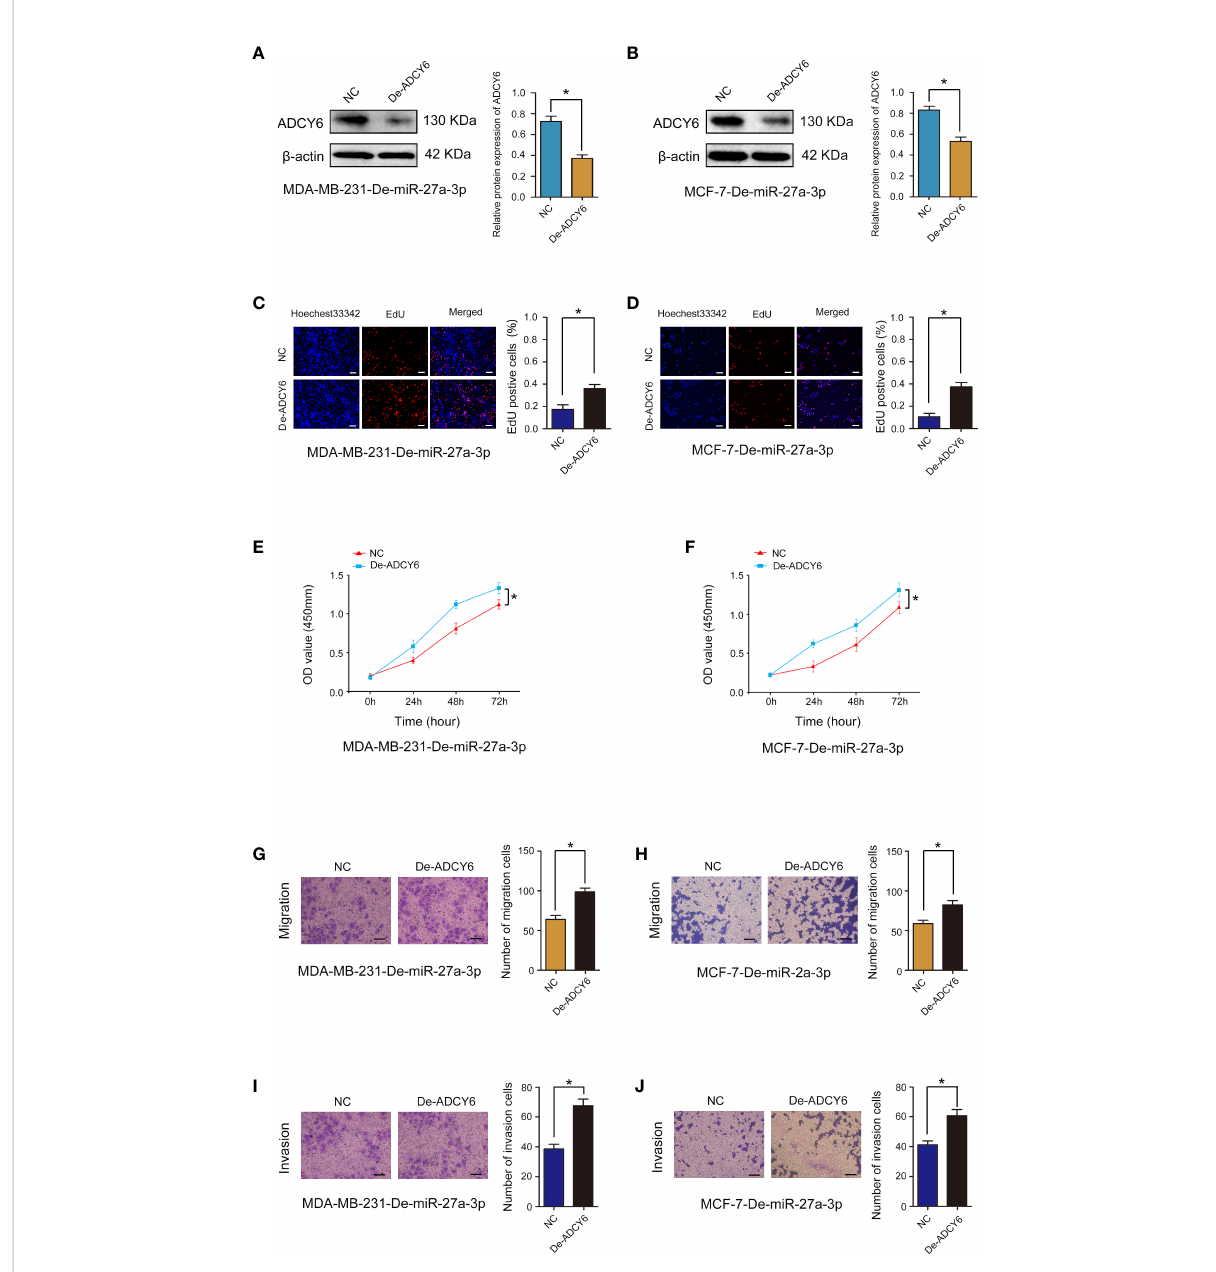
FIGURE 8 Rescue experiments were performed to con fi rm that ADCY6 ameliorates the promoting effect of miR-27a-3p on BCa progression. (A) The protein expression of ADCY6 after decreasing the expression of ADCY6 in MDA-MB-231-De-miR-27a-3p cells. *p < 0.05 versus controls. (B) The protein expression of ADCY6 after decreasing the expression of ADCY6 in MCF-7- De-miR-27a-3p cells. *p < 0.05 versus controls. (C) The uptake capacity of EdU in MDA-MB-231-De-miR-27a-3p cells that decreased the expression of ADCY6 was determined by EdU assay. Scale bars, 50 µm. *p < 0.05 versus controls. (D) The uptake capacity of EdU in MCF-7-De-miR-27a-3p cells that decreased the expression of ADCY6 was determined by EdU assay. Scale bars, 50 µm. *p < 0.05 versus controls. (E) The proliferation of MDA-MB-231-De-miR-27a-3p cells that decreased the expression of ADCY6 was determined by CCK-8 assay. *p < 0.05 versus controls. (F) The proliferation of MCF-7-De-miR-27a-3p cells that decreased the expression of ADCY6 was determined by CCK-8 assay. *p < 0.05 versus controls. (G) The migration of MDA-MB-231- De-miR-27a-3p cells that decreased the expression of ADCY6 was determined by Transwell assay. *p < 0.05 versus controls. (H) The migration of MCF-7-De-miR-27a-3p cells that decreased the expression of ADCY6 was determined by Transwell assay. *p < 0.05 versus controls. (I) The invasion of MDA-MB-231-De-miR-27a-3p cells that decreased the expression of ADCY6 was determined by Transwell assay. *p < 0.05 versus controls. (J) The invasion of MCF-7-De-miR-27a-3p cells that decreased the expression of ADCY6 was determined by Transwell assay. *p < 0.05 versus